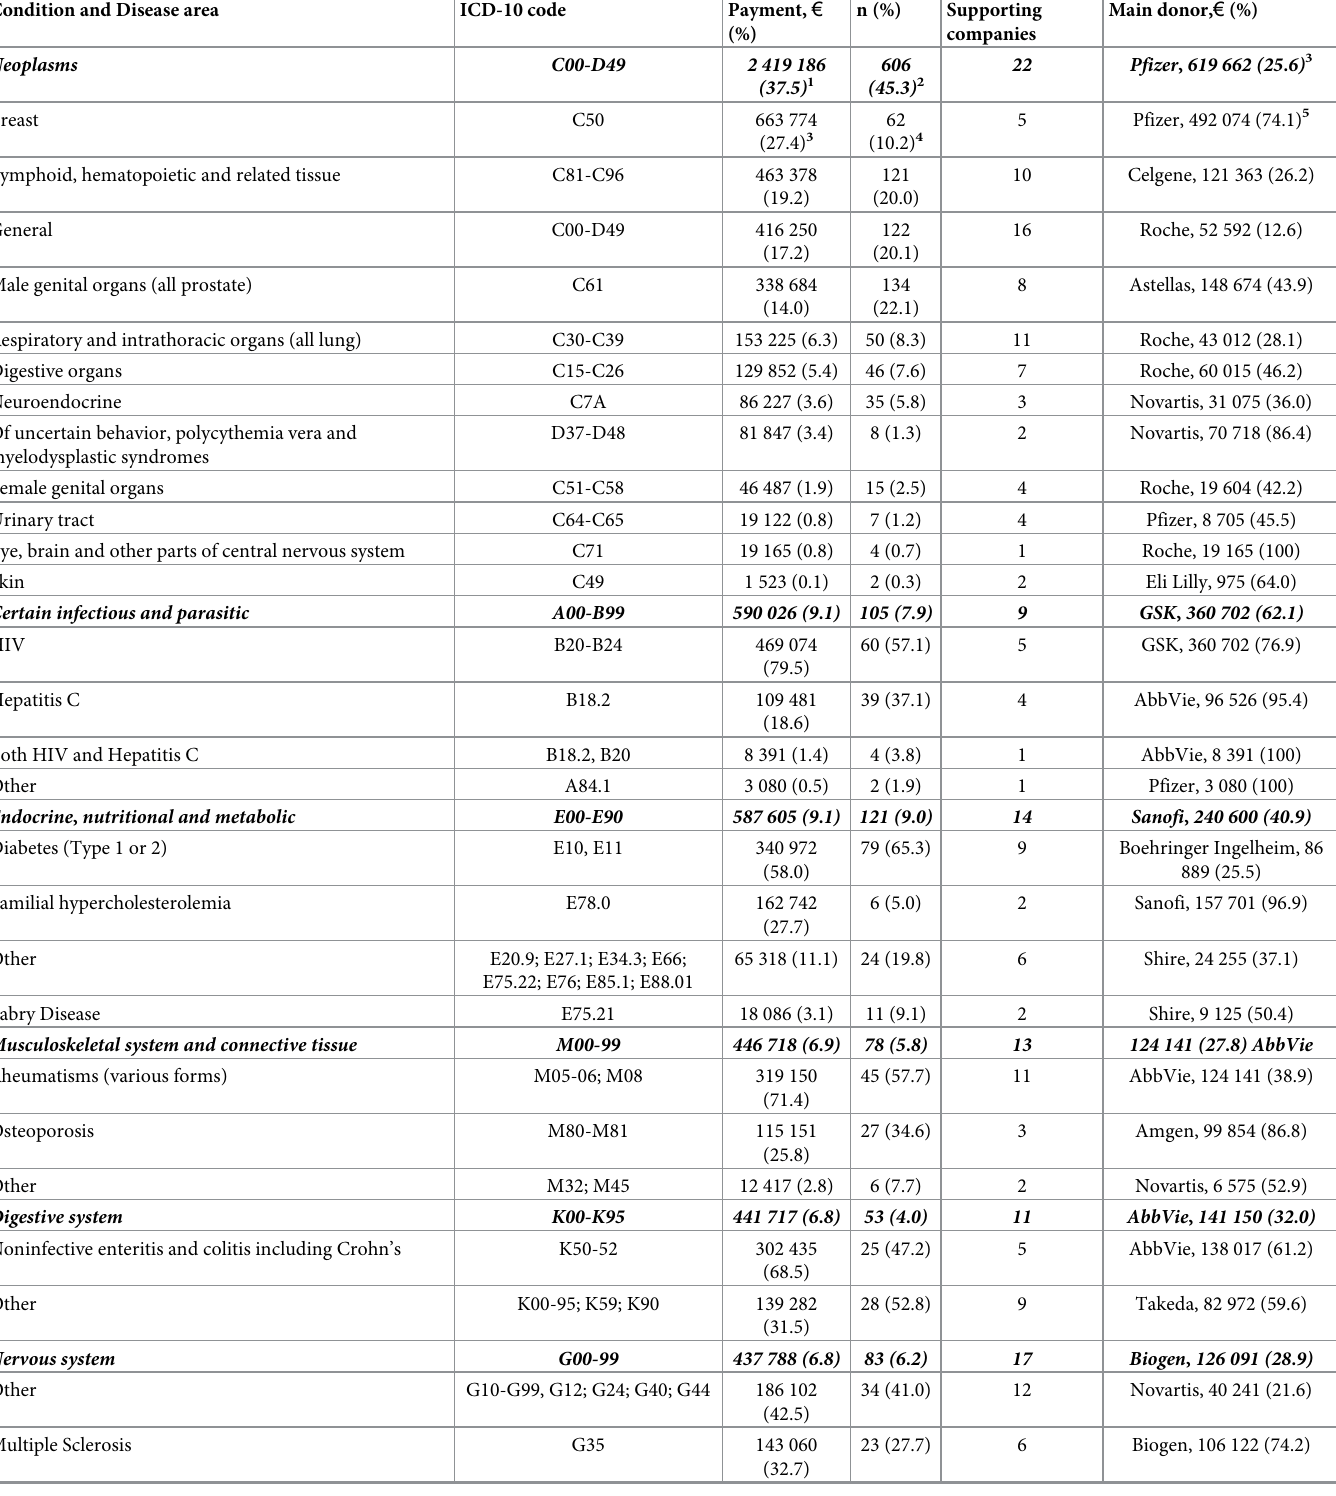
Table 5. Reported drug industry funding of patient organisations in Sweden across condition and disease areas